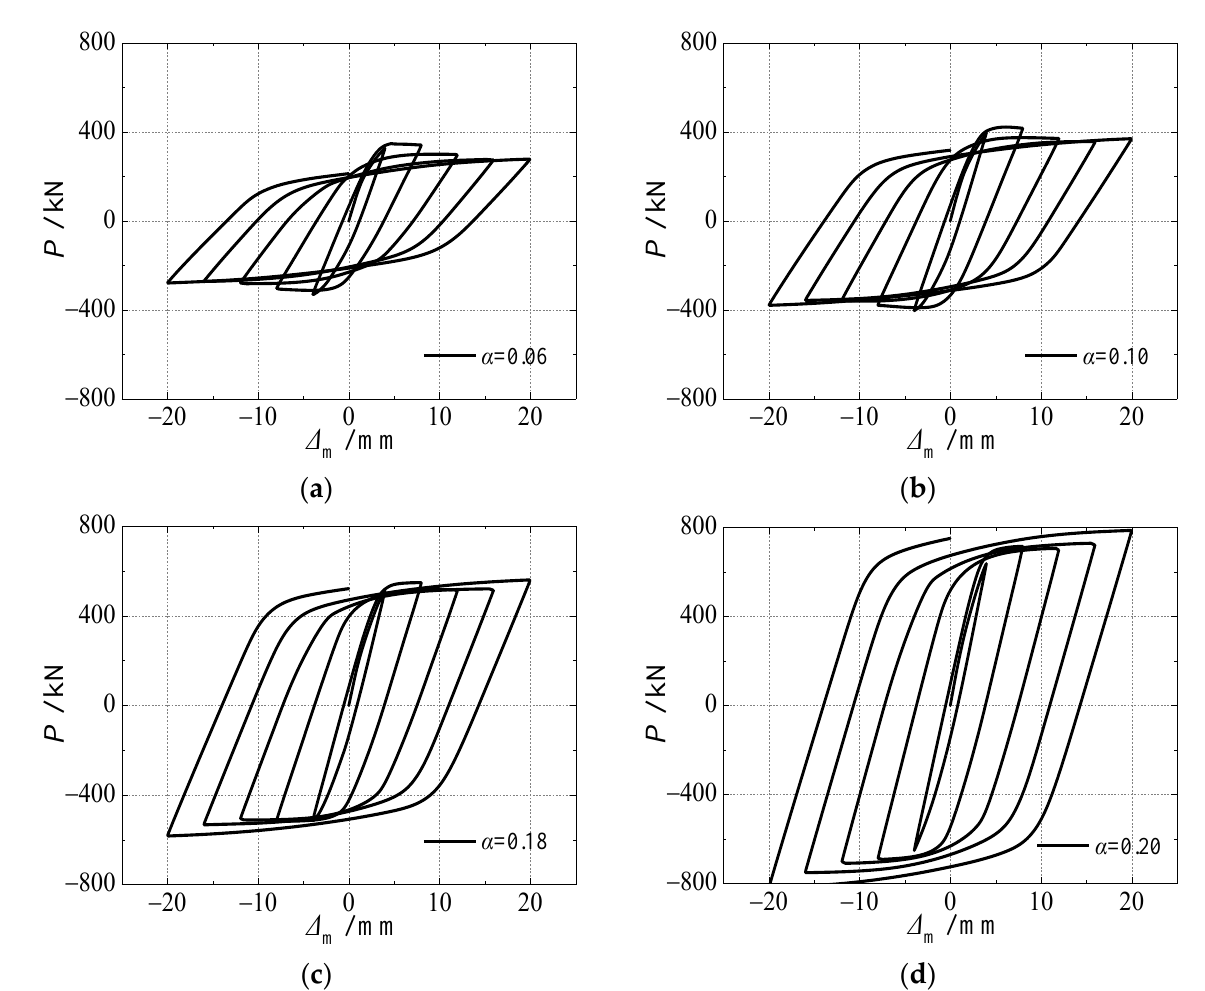
Figure 17. Effect of steel ratio on hysteretic curve. ( a ) α = 0.06; ( b ) α = 0.10; ( c ) α = 0.18; ( d ) α = 0.20.